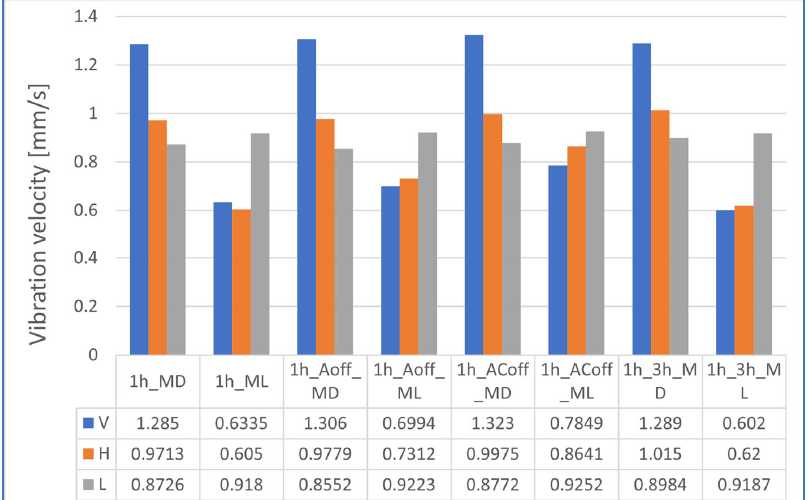
Figure 9. Vibration RMS distribution characteristics for an unloaded motor and a rotational speed of 750 rpm.